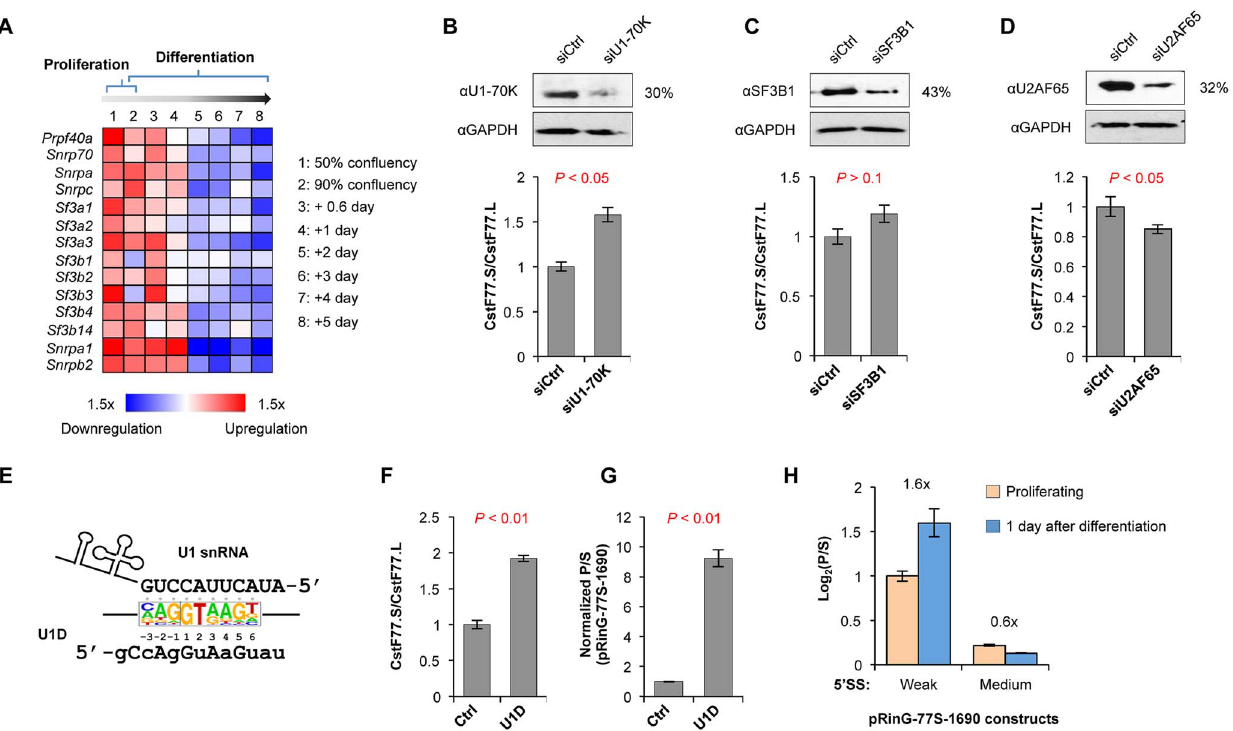
Figure 6. U1 snRNP regulates the usage of intronic pA of CstF-77 gene. ( A ) Regulation of expression of factors in U1 and U2 snRNPs in C2C12 differentiation. Expression analysis was based on a microarray dataset from the GEO database (GSE11415). Expression changes are represented by colors based on the scale shown at the bottom of the graph. ( B ) Effect of knockdown of U1-70K on the CstF-77.S/CstF-77.L ratio. Top, Immunoblot (IB) showing knockdown efficiency; bottom, CstF-77.S/CstF-77.L ratio as measured by RT-qPCR. P-value (T-test) comparing knockdown and control siRNA samples is shown. ( C ) and ( D ) As in (B), except that knockdowns of SF3B1 (C) and U2AF65 (D) are shown. ( E ) Inhibition of U1 snRNP interaction with 5 9 SS by U1D oligo. Sequence of the 5 9 region of U1 snRNA is shown. The consensus sequence of the 5 9 SS of all RefSeq-supported human introns is represented by a sequence logo. U1D sequence is also shown (locked nucleic acid (LNA) residues are in uppercase and 2 9 -OMe RNA residues are in lowercase, see Materials and Methods for detail). ( F ) Effect of U1D on the CstF-77.S/CstF-77.L ratio. ( G ) Effect of U1D on the (isoform P)/(isoform S) ratio for pRinG-77S-1690. ( H ) The (isoform P)/(isoform S) ratios for pRinG-77S-1690 vectors with weak or medium strength 5 9 SS in proliferating and differentiating (1 day of differentiation) cells. See Figure 2D for 5 9 SS sequences. The ratio of the log 2 (P/S) value from proliferating cells to that from differentiating cells is indicated, where P represents the abundance of isoform P and S the abundance of isoform S. The difference in log 2 (P/S) value (proliferating cells vs. differentiating cells) is statistically significant ( P , 0.05, T-test) for all two constructs.